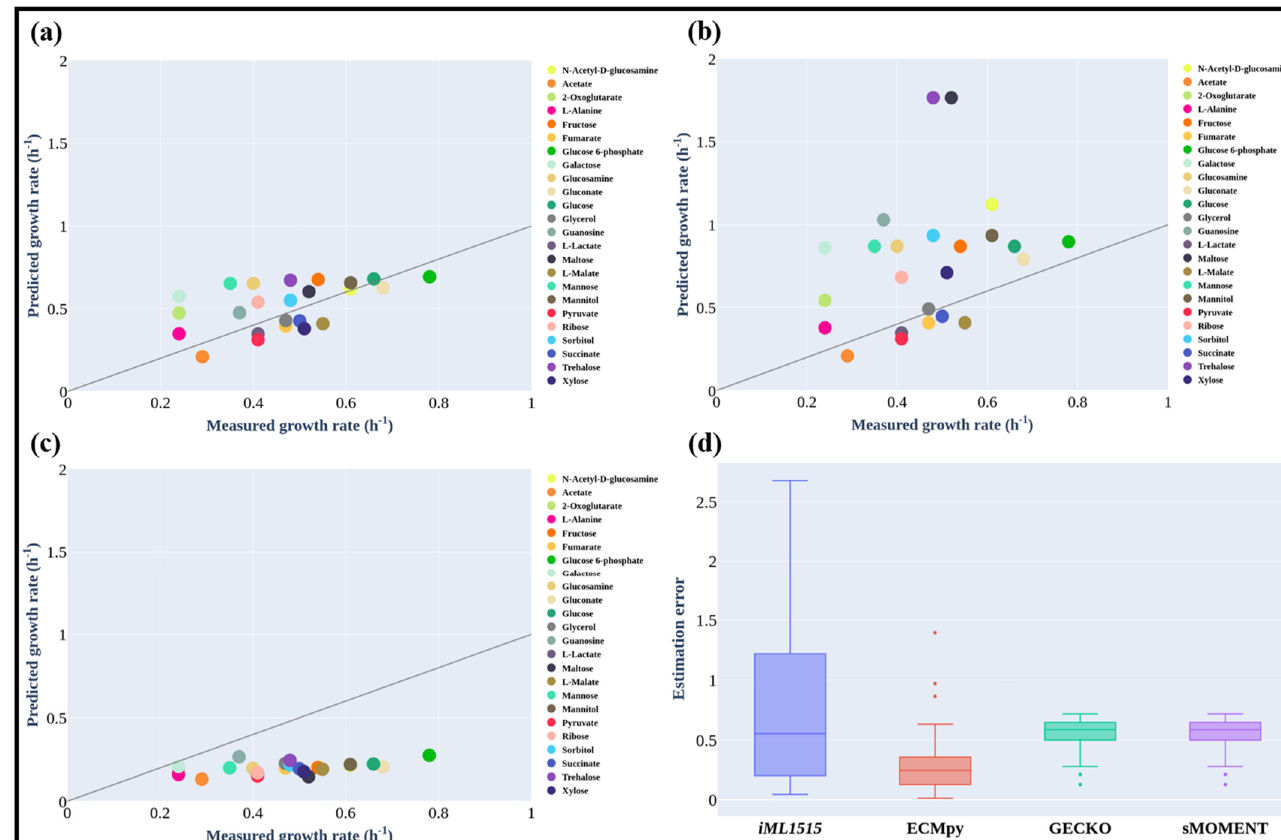
Figure 4. Predicted E. coli Growth Rates on Different Carbon Sources Using ECMpy ( a ), i ML1515 ( b ), GECKO and sMOMENT ( c ). ( d ) Distribution of prediction errors of internal fluxes from different models (GECKO and sMOMENT with consideration of protein subunits). Biomolecules 2022 , 12 , x